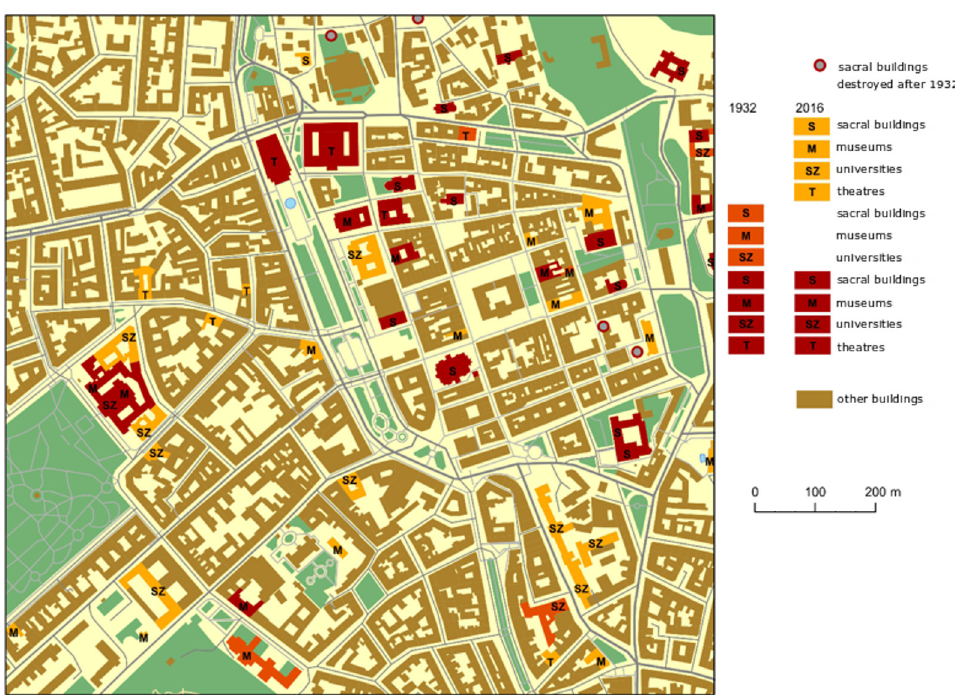
Fig. 5. The location of buildings with selected functions in 1932 and 2016 (part of the map; own work based on OpenStreetMap vector